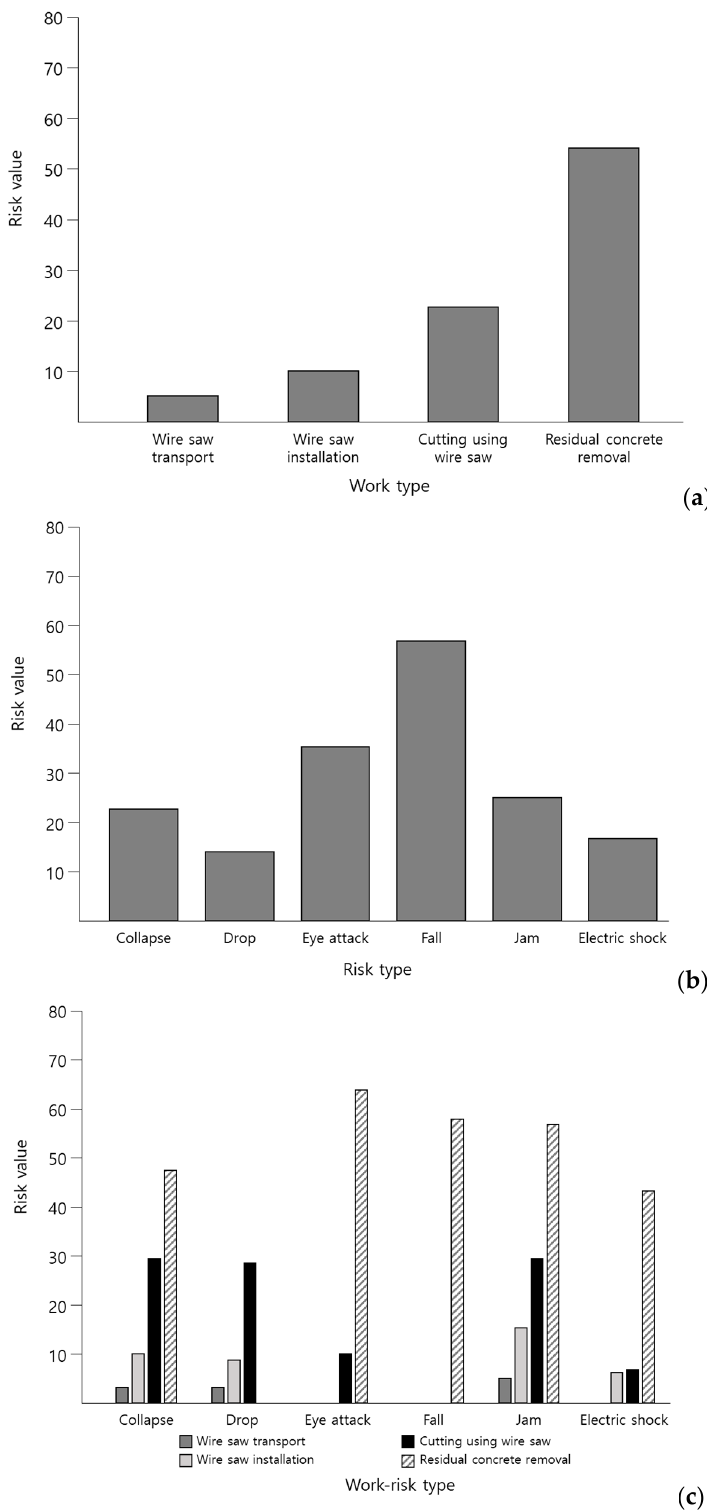
Figure 3. Comparison of risk assessment: ( a ) risk by work; ( b ) risk by risk type; ( c ) risk graph by risk type of work.